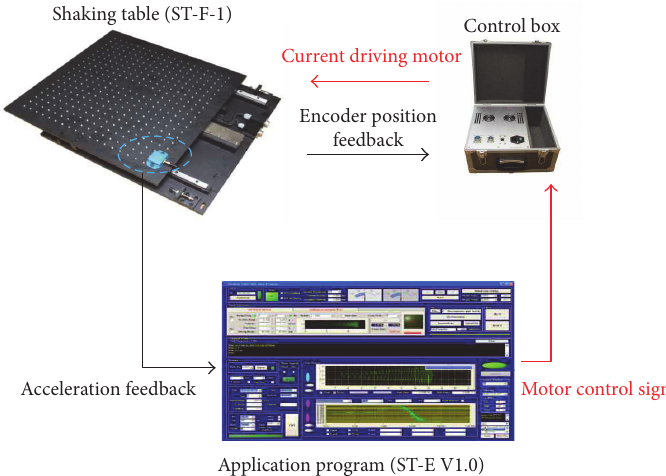
Figure 4: Application process of the dynamic load to the structure by using a shaking table.